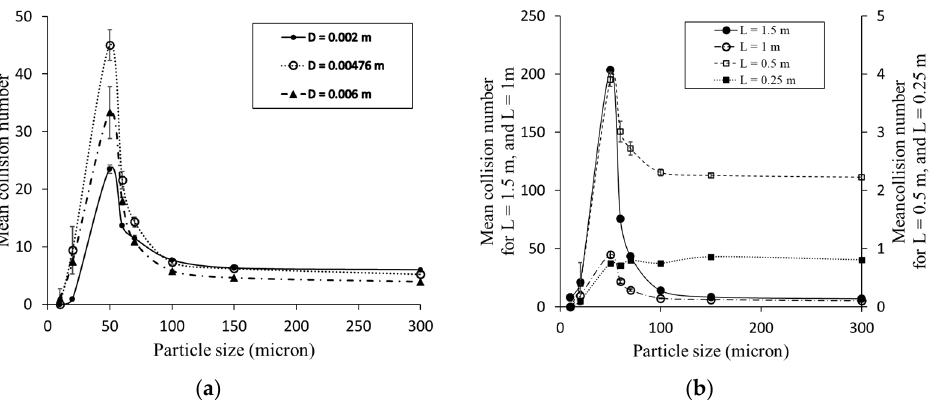
Figure 6. ( a ) Influence of pipe diameter on particle-wall mean collision number. In all cases, particles were released into a 1 m pipe with 8.4 (m/s) air velocity; ( b ) influence of pipe length on particle-wall interactions. In all cases, particles were released into a pipe with 4.76 mm inner diameter and 8.4 (m/s) air velocity.